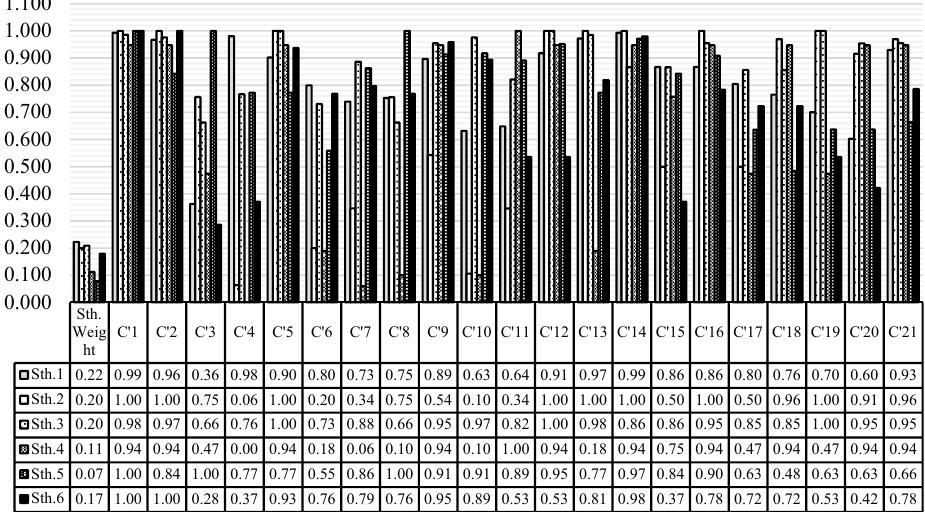
Figure 5. Assigned weights for the initial criteria by the stakeholders of the Kashafroud watershed.